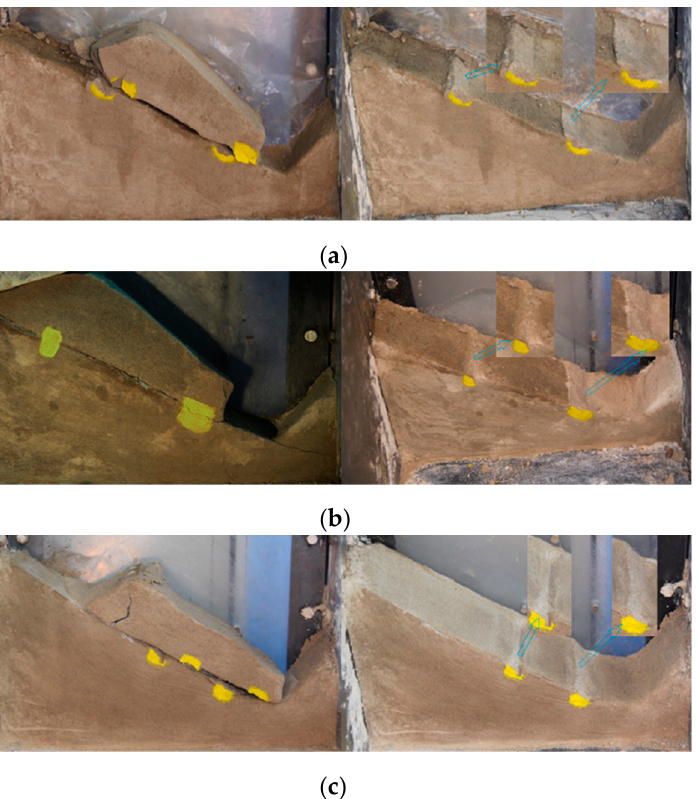
Figure 10. Rockslides reproduced in the physical experiment. ( a ) Same-length locked patches with a large spacing, ( b ) short upper locked patch with a large spacing, ( c ) same-length locked patches with a small spacing (Reprinted with permission from [17] , 2021, Springer Nature).